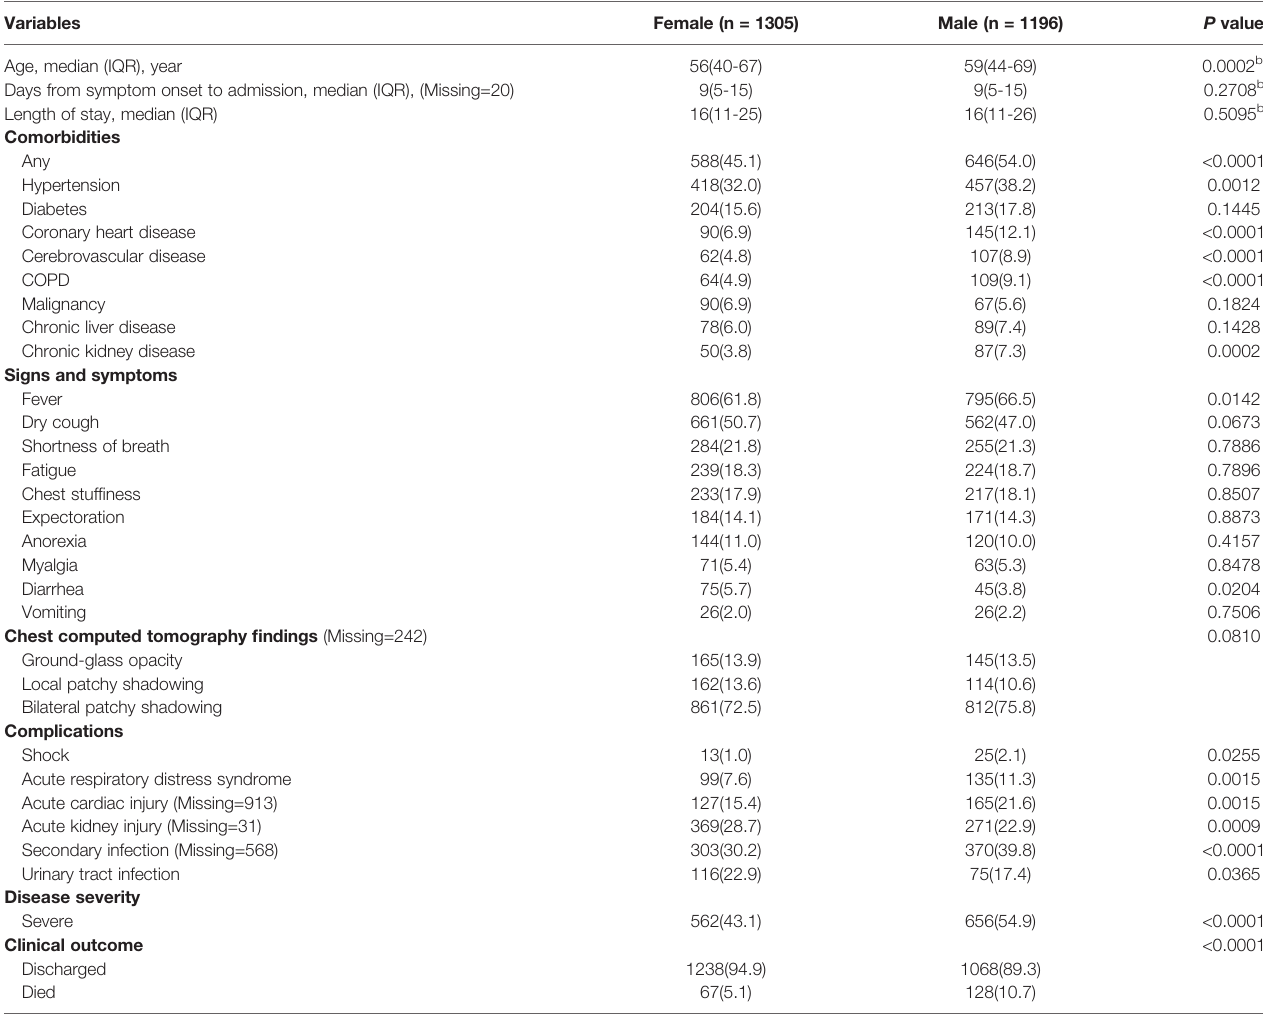
TABLE 1 | Clinical characteristics on admission and outcomes in male and female patients with COVID-19 a .